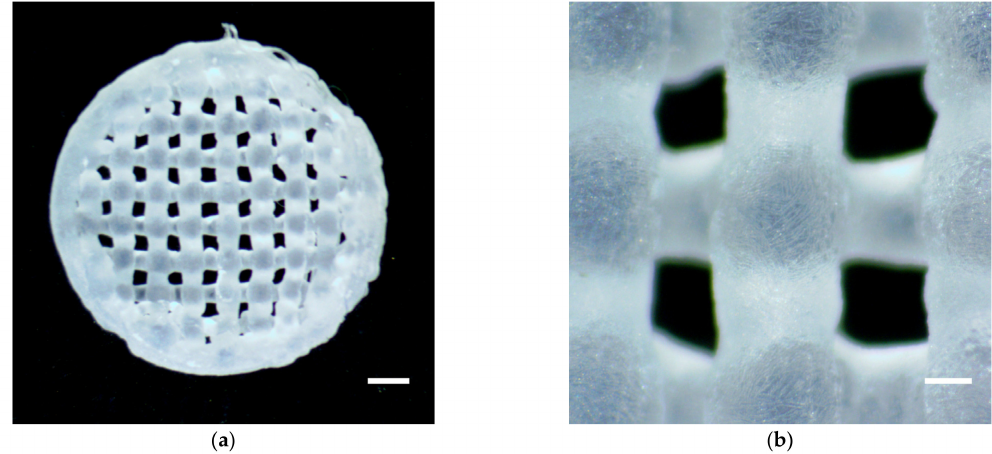
Figure 1. SA-based gene-activated hydrogel scaffold formed with 3D cryoprinter. ( a ) General view.